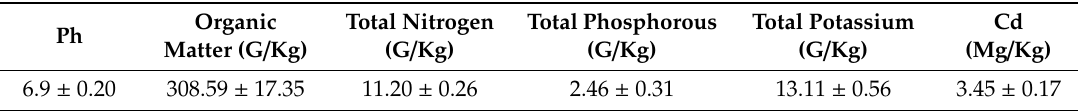
Table 1. Basic physicochemical properties of